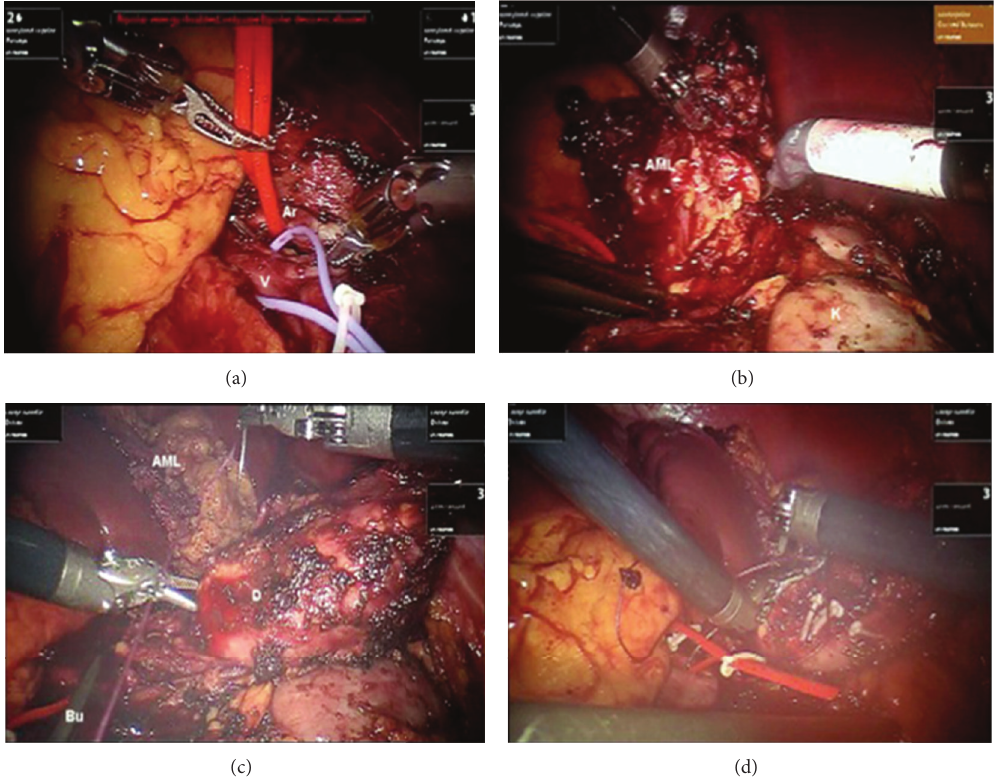
Figure2:IntraoperativeimagesduringRALPN.(a)Therenalartery(Ar)andvein(V)areidentified.(b)DissectionoftheAMLfromtheupper pole of the kidney (K). (c) Clamping the renal artery with a laparoscopic Bulldog clamp (Bu) for suturing the renal defect (D). (d) Suturing the renal defect.